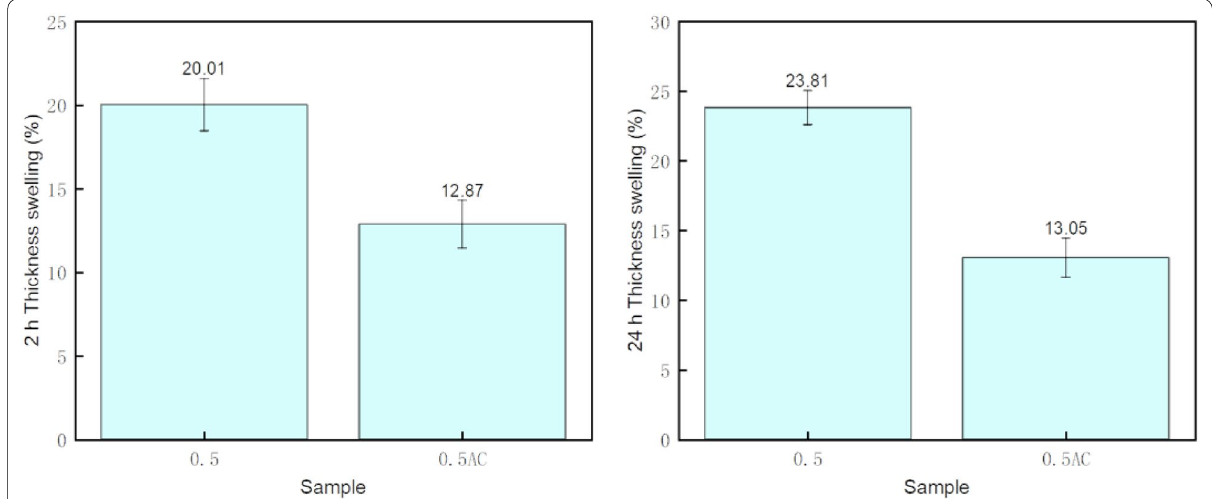
Fig. 8 The thickness swelling rate of water absorption of samples with foaming agent and the control group with density 0.5 g/cm